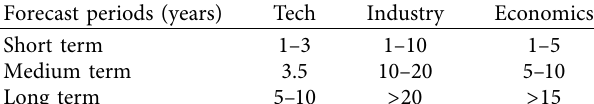
Table 1: Classification of forecast periods in typical domains.